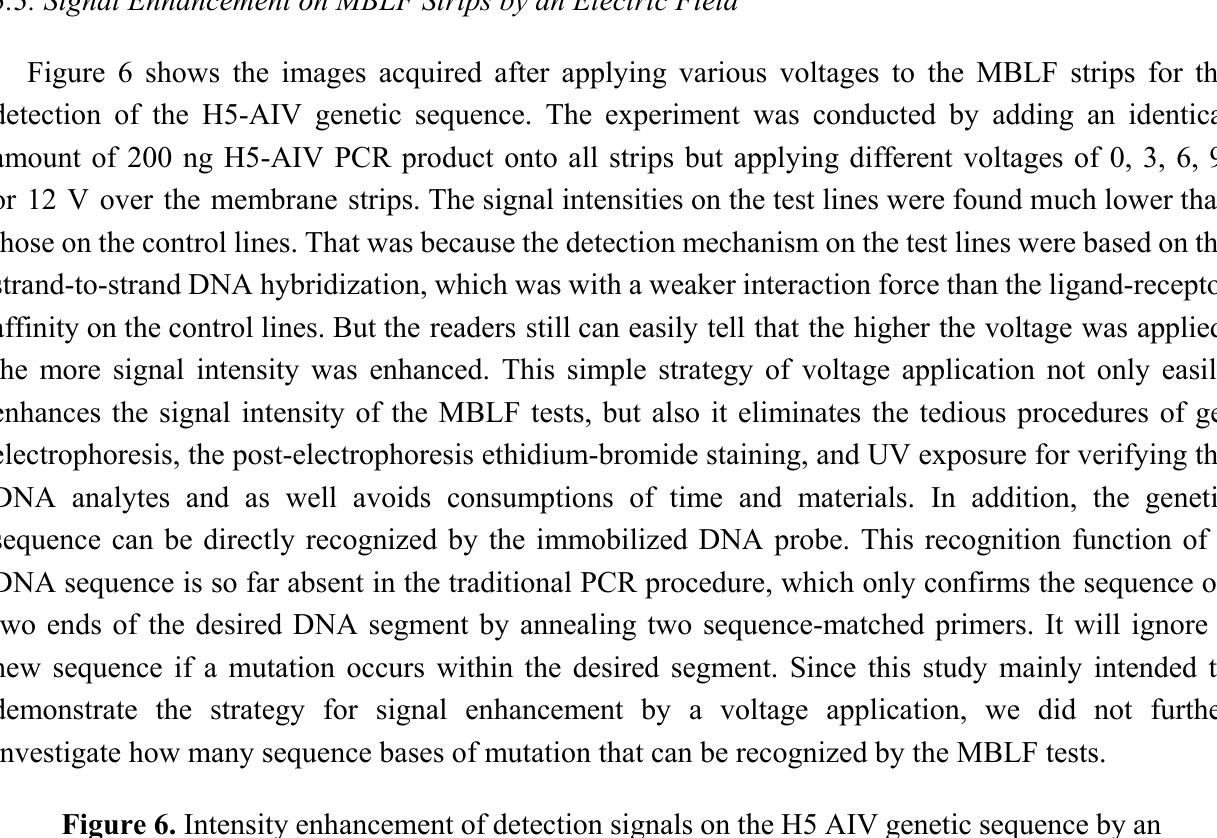
Figure 6. Intensity enhancement of detection signals on the H5 AIV genetic sequence by an electric field. ( a ) Image of the strip test. Each strip was applied various voltages, from 0 to 12 V. The strip width was 5 mm and the quantity of the H5 AIV analyte loaded was 200 ng. ( b ) Quantitative analysis of the signal